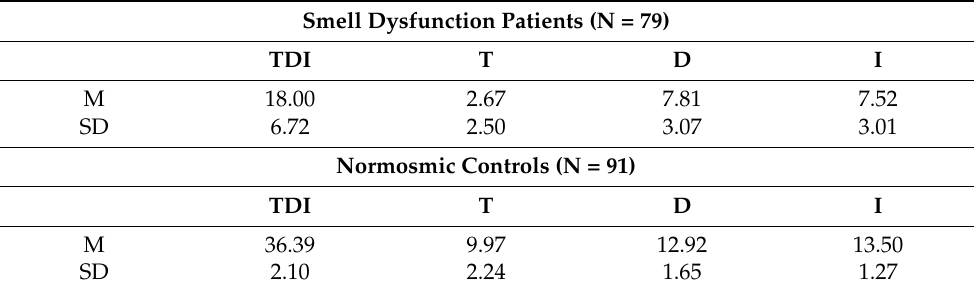
Table 1. Participant’s TDI Scores (sum score (TDI) for threshold (T), discrimination (D), and identifi- cation (I) of the odors; means (M), standard deviations